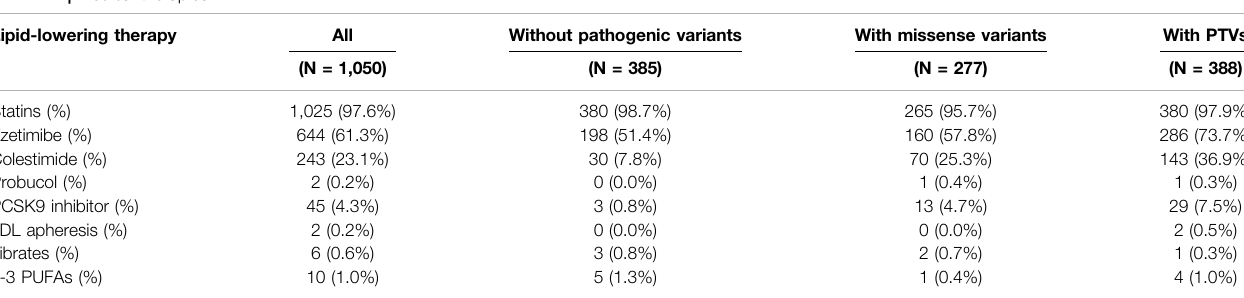
TABLE 2 | Medical therapies.